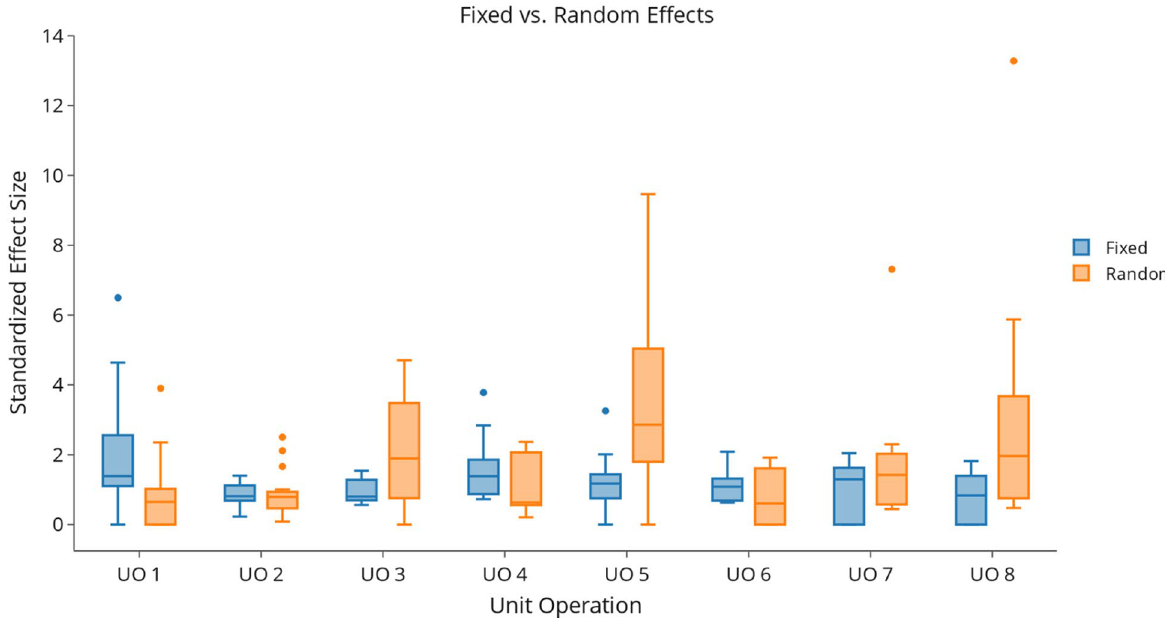
Fig. 3 Standardized fixed and random effect sizes are contrasted for each unit operation. A unit operation contains models for 11–22 CQAs, and their respective fixed and random effect distributions are shown as box plots. To create comparable measures of effect size, normalized data were used to fit the models, and the effects were divided by the RMSE. Note that for several unit operations, the median random effect is even